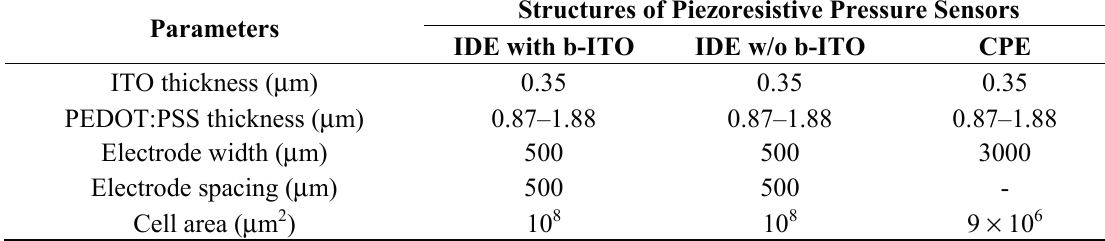
Figure 2. Schematic diagrams of the poly(3,4-ethylenedioxythiophene):polystyrene sulfonate (PEDOT:PSS) pressure sensors with cross-point electrode (CPE) structures for ( a ) part I; ( b ) part II; and ( c ) the final device with image picture; and ( d ) the cross-sectional diagram of the pressure sensors with CPE structures. Table 1. Summary of all parameters of the piezoresistive pressure sensors with inter-digitated electrode (IDE) with bottom indium-tin-oxide (b-ITO), without b-ITO and cross-point electrode (CPE)